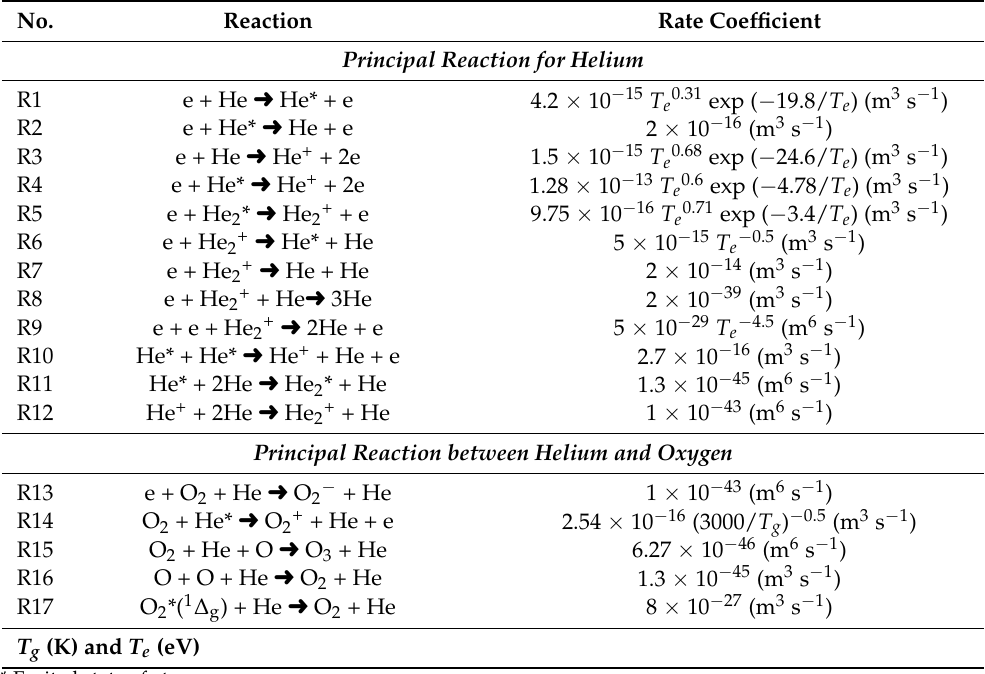
Table 4. List of reactions for helium in He/O 2